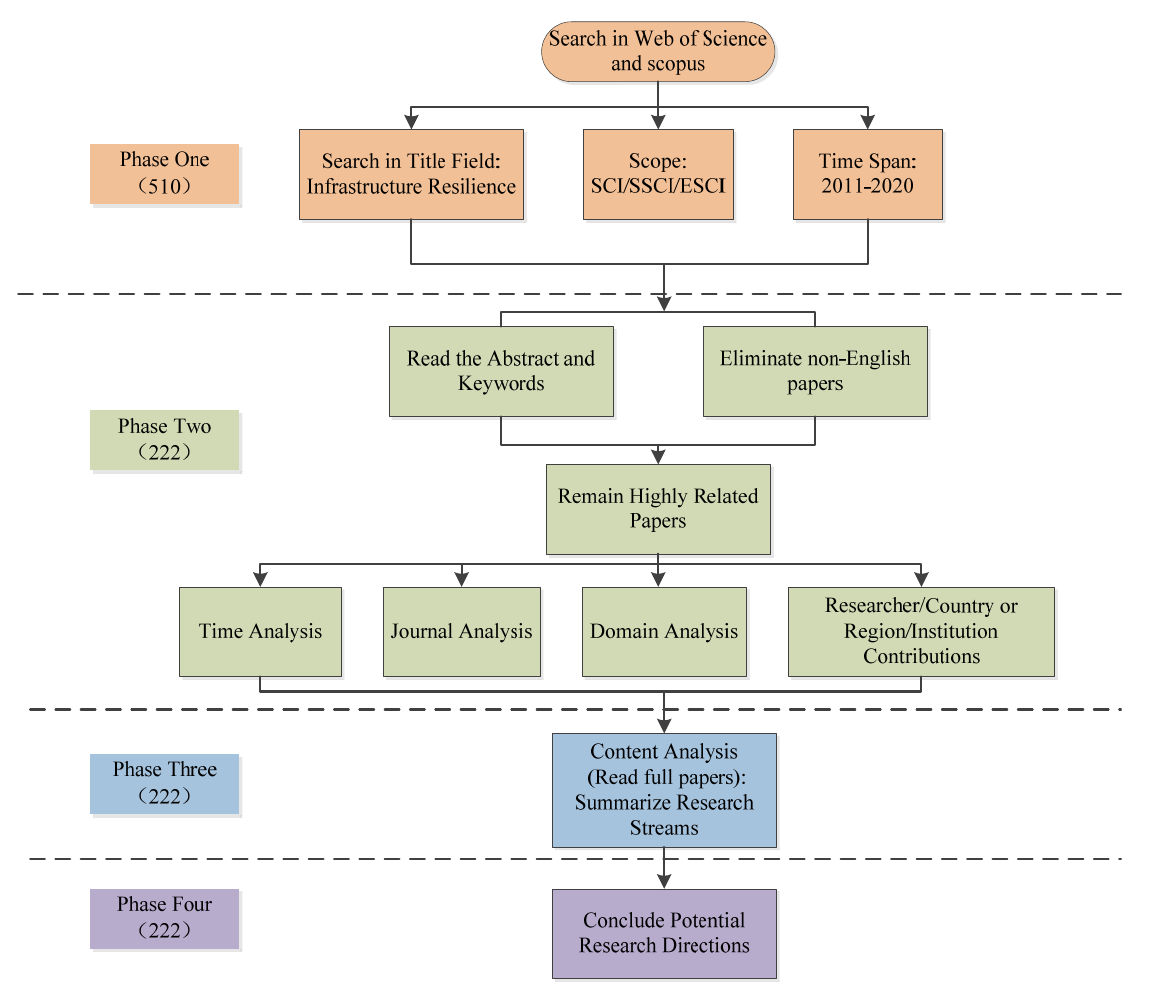
Figure 1. Literature review framework.